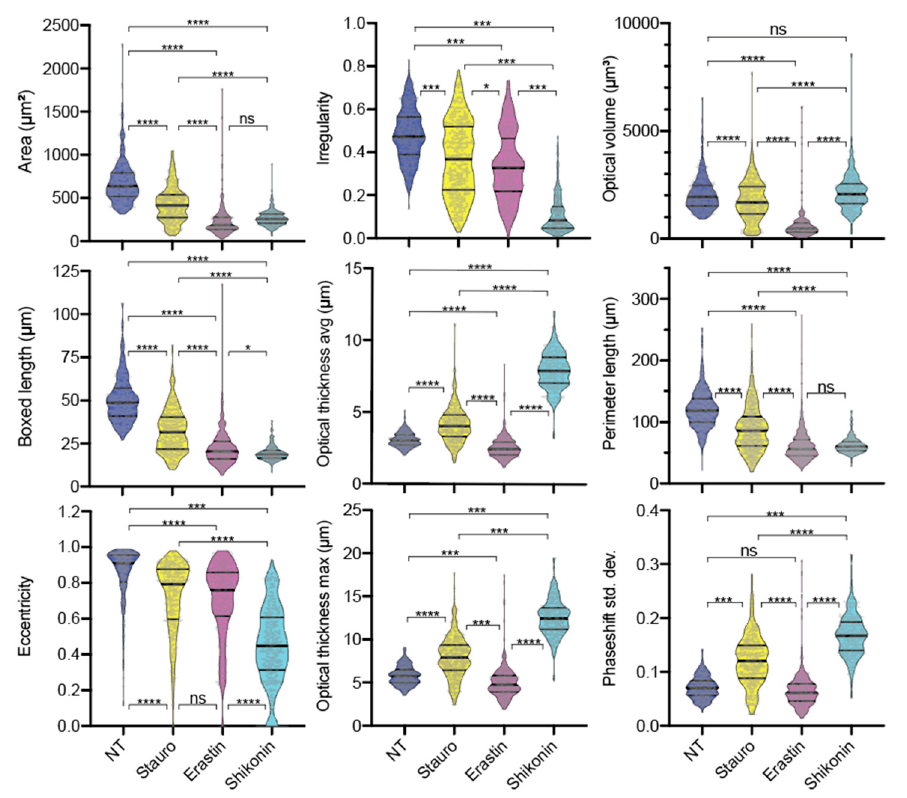
Figure 5. Distributions of indicated DHC-derived single cell features across four conditions. Data represent Training Set only. Ordinary one-way ANOVA with Tukey's multiple comparisons test; Adjusted P value > 0.05 (n.s.), < 0.05 (*), < 0.01 (**), < 0.001 (***), or < 0.0001(****).